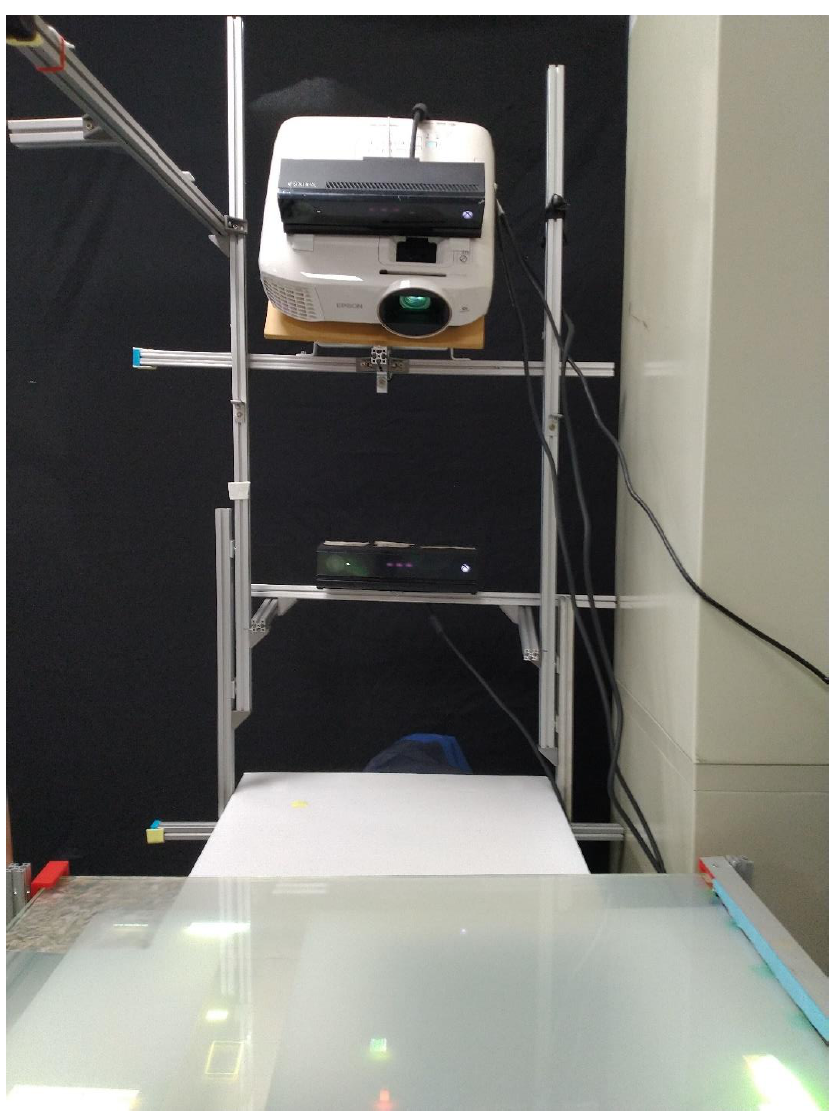
Figure 2. Developed Inspection System Setup.